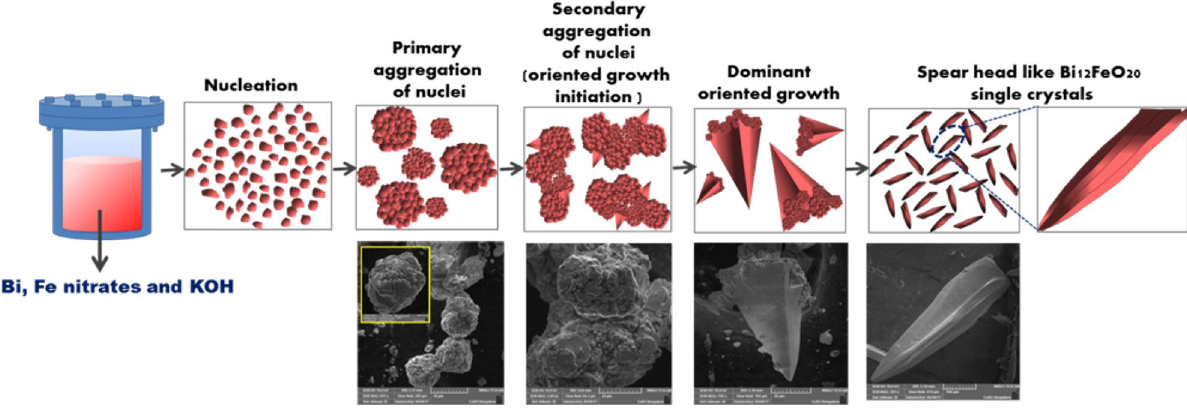
Figure 3. Schematic illustrations of hydrothermally grown spear head like Bi 12 FeO 20 single crystals with corresponding SEM images.